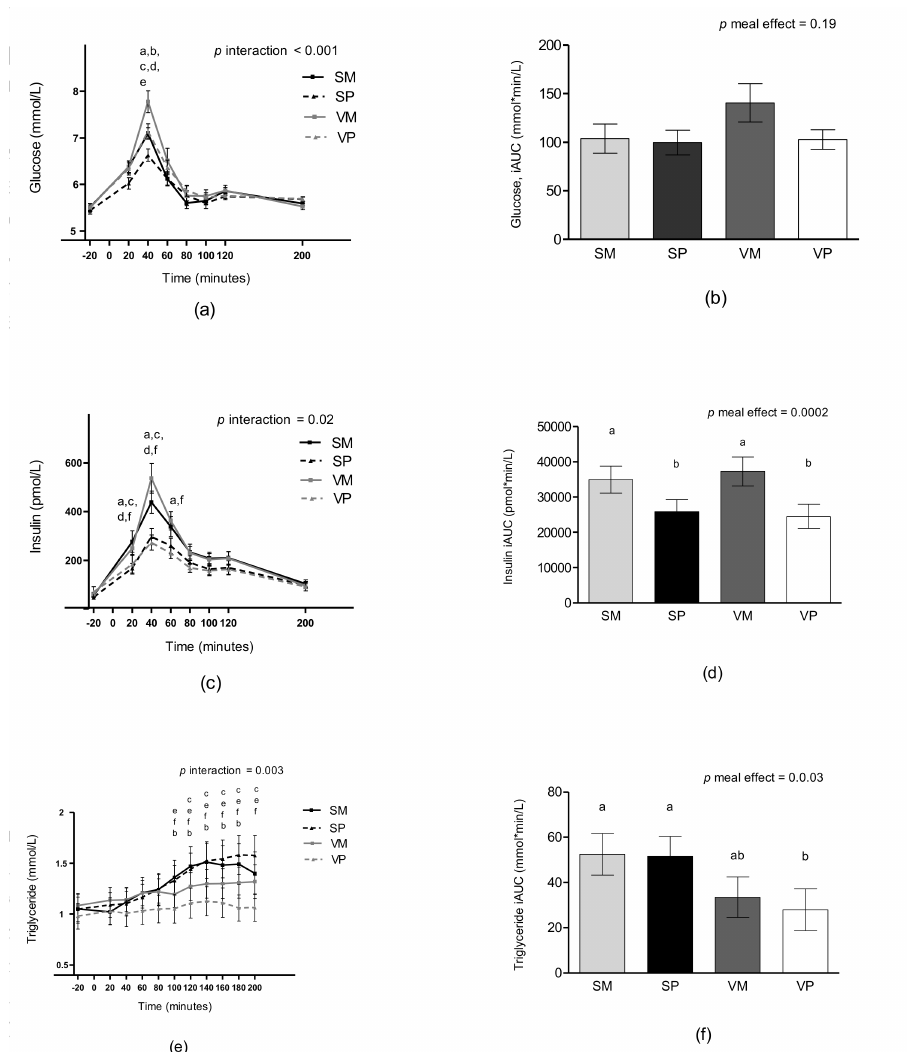
Figure 4. Mean unadjusted concentrations of plasma glucose ( a ), plasma glucose iAUC ( b ), serum insulin ( c ), serum insulin iAUC ( d ), plasma triglyceride ( e ), and plasma triglyceride iAUC ( f )